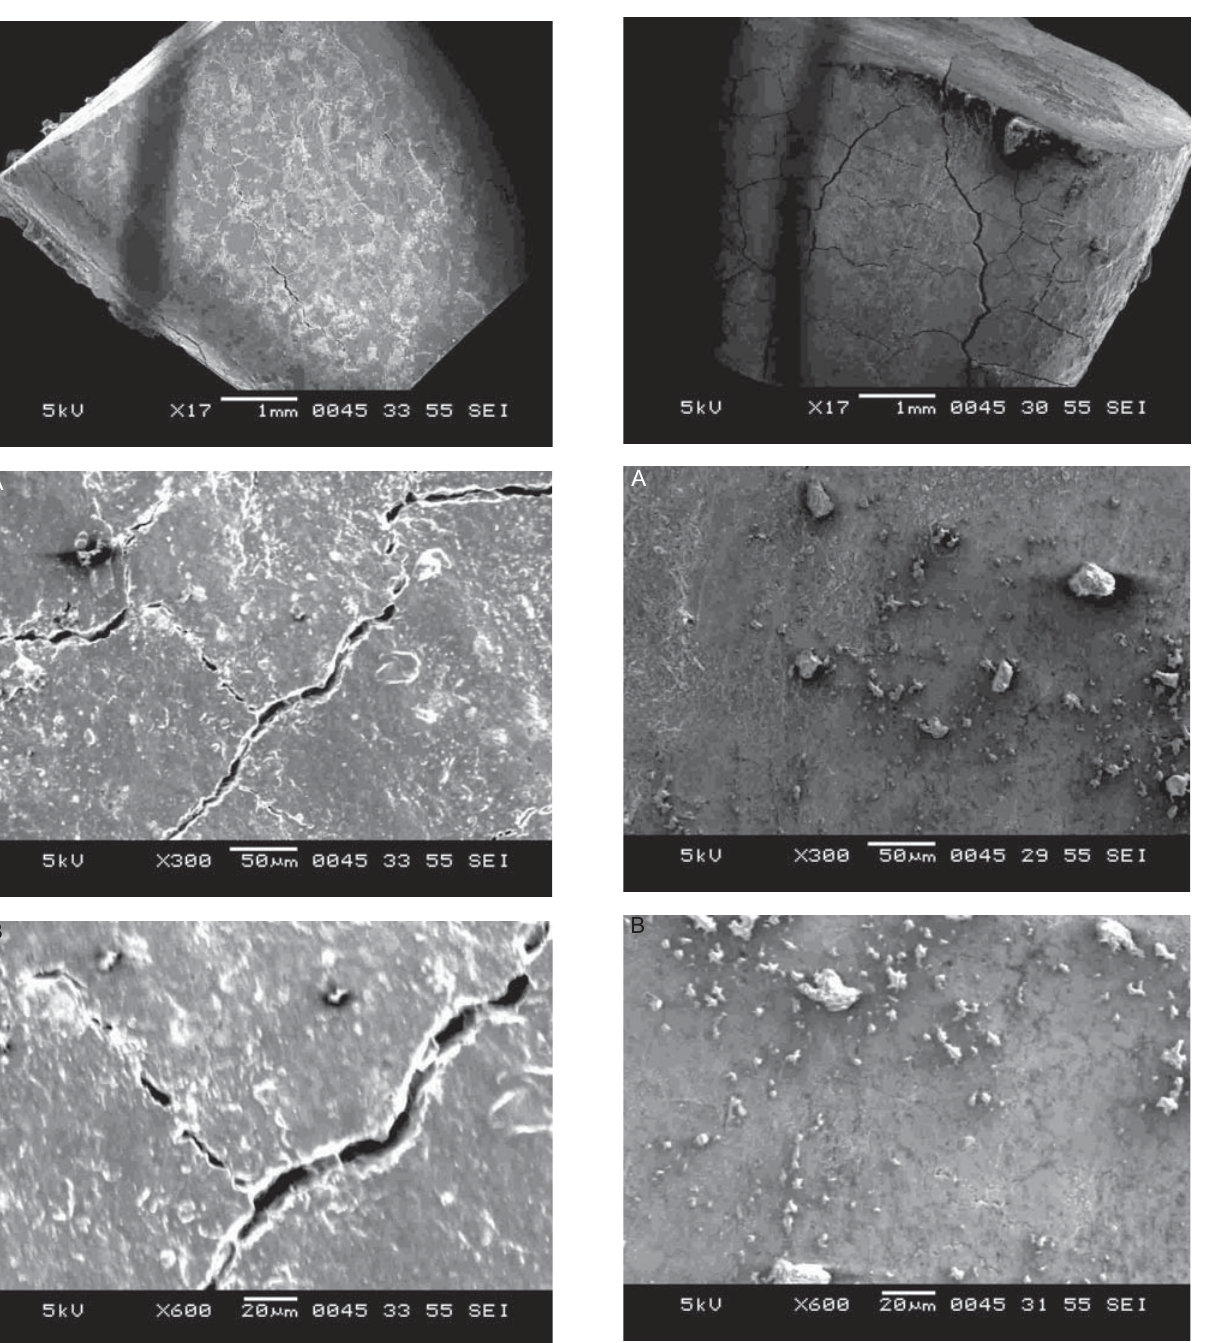
Figure 4- Scanning electron microscopy (SEM) view of group B sample. A: SEM view of group B sample at 300x (cid:2)(cid:3)(cid:4)(cid:5)(cid:6)(cid:7)(cid:8)(cid:3)(cid:9)(cid:6)(cid:10)(cid:5)(cid:31)(cid:12)(cid:13)(cid:14)(cid:12)(cid:15)(cid:16)(cid:17)(cid:12)(cid:18)(cid:6)(cid:19)(cid:20)(cid:12)(cid:10)(cid:21)(cid:12)(cid:4)(cid:22)(cid:10)(cid:23)(cid:24)(cid:12)(cid:13)(cid:12)(cid:26)(cid:3)(cid:2)(cid:24)(cid:27)(cid:19)(cid:12)(cid:3)(cid:9)(cid:12)(cid:28)(cid:29)(cid:29)(cid:30)(cid:12) (cid:2)(cid:3)(cid:4)(cid:5)(cid:6)(cid:7)(cid:8)(cid:3)(cid:9)(cid:6)(cid:10)(cid:5)